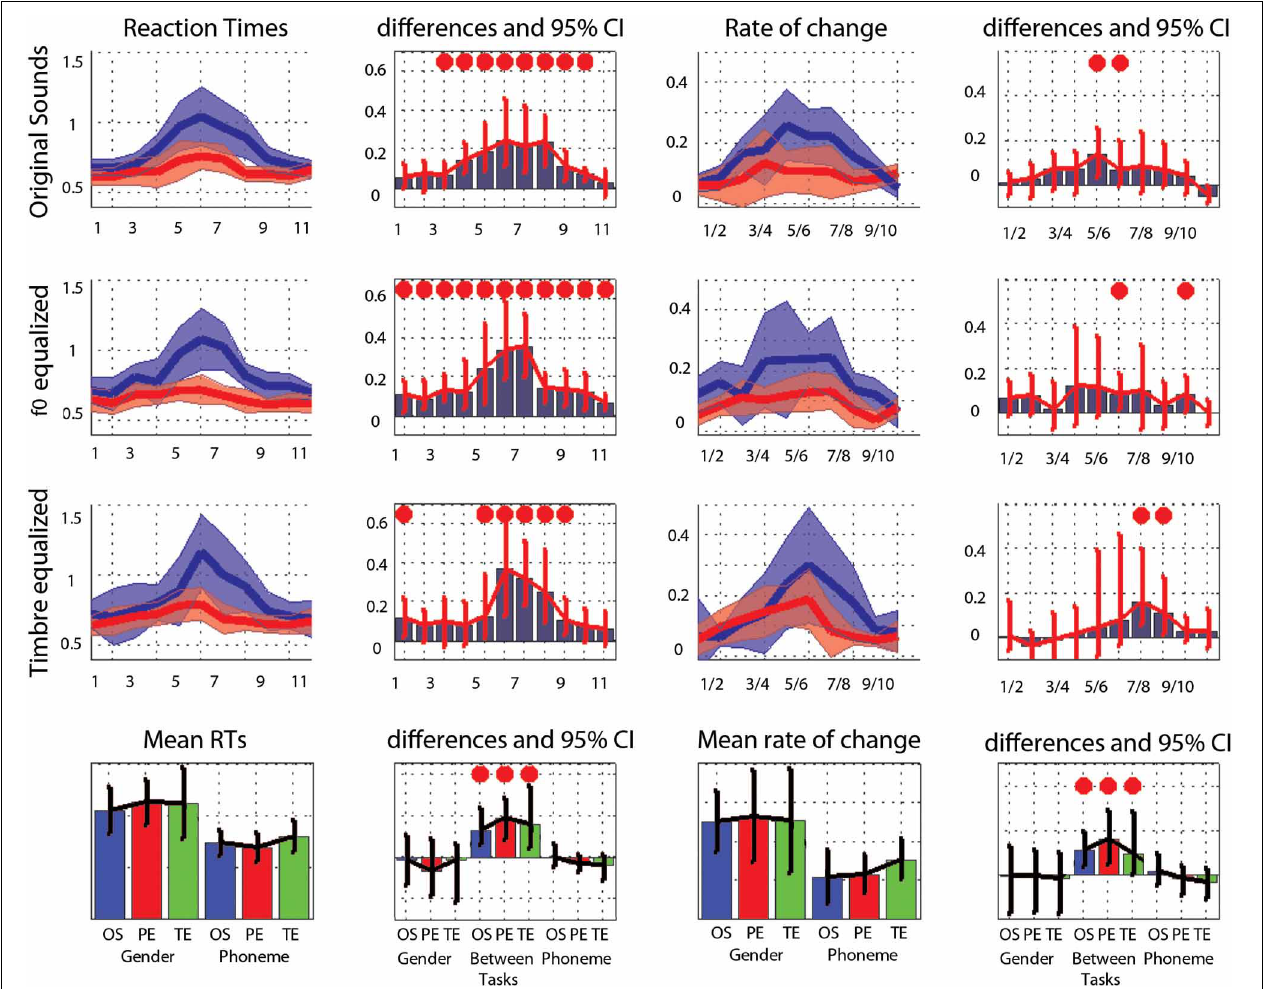
FIGURE 3 | Trimmed mean reaction times between tasks and per condition. For the first three rows, from left to right are displayed: (i) the 95% CI of reaction times curves in the gender task (blue) and the phoneme task (red), (ii) the differences between tasks in RT computed for each step (significant differences with adjustment for multiple comparisons marked by a red dot), (iii) the rate of change in RT measured between each successive pairs (1st derivative) (iv) the differences between tasks in the rate of change